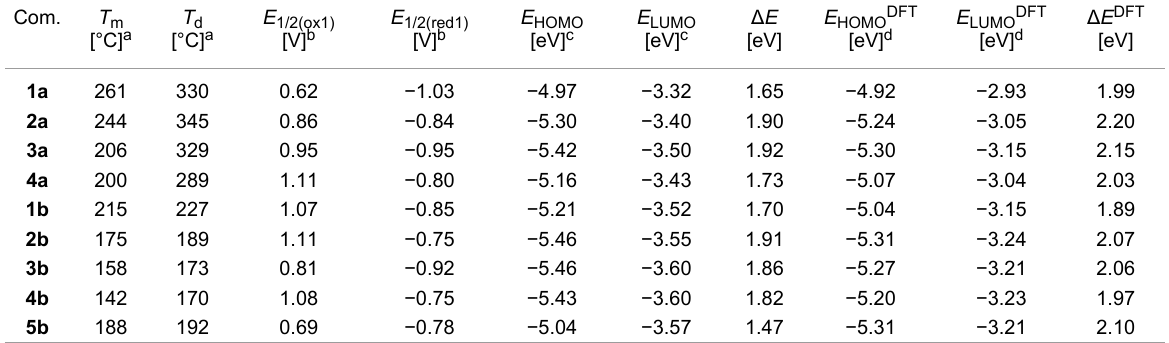
Table 1: Thermal, electrochemical, and DFT calculated data for chromophores 1 – 5 .